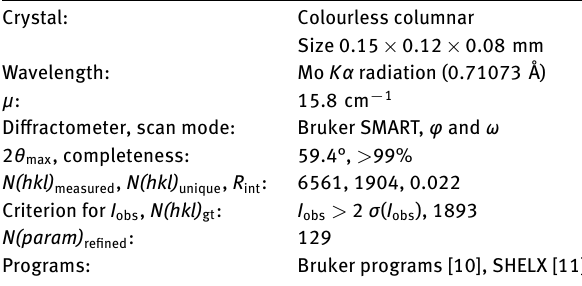
Table 2: Fractional atomic coordinates and isotropic or equivalent isotropic displacement parameters (Å 2